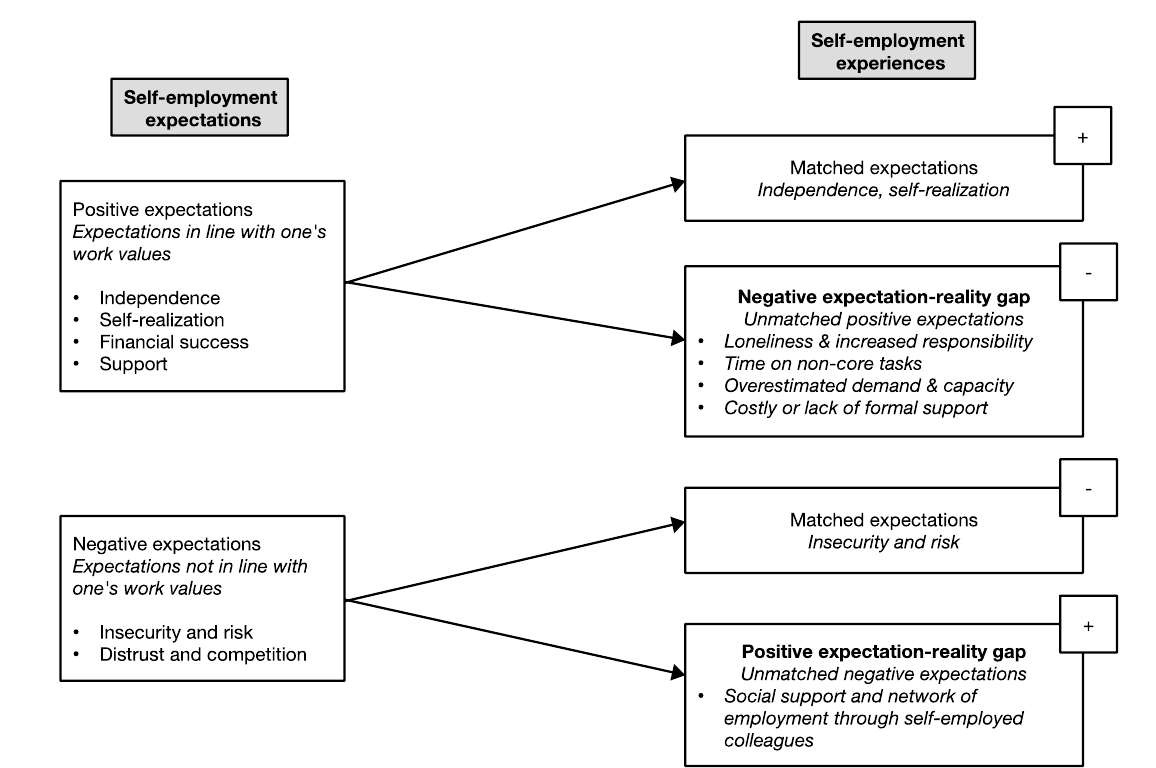
Figure 2. Visual diagram of main findings.